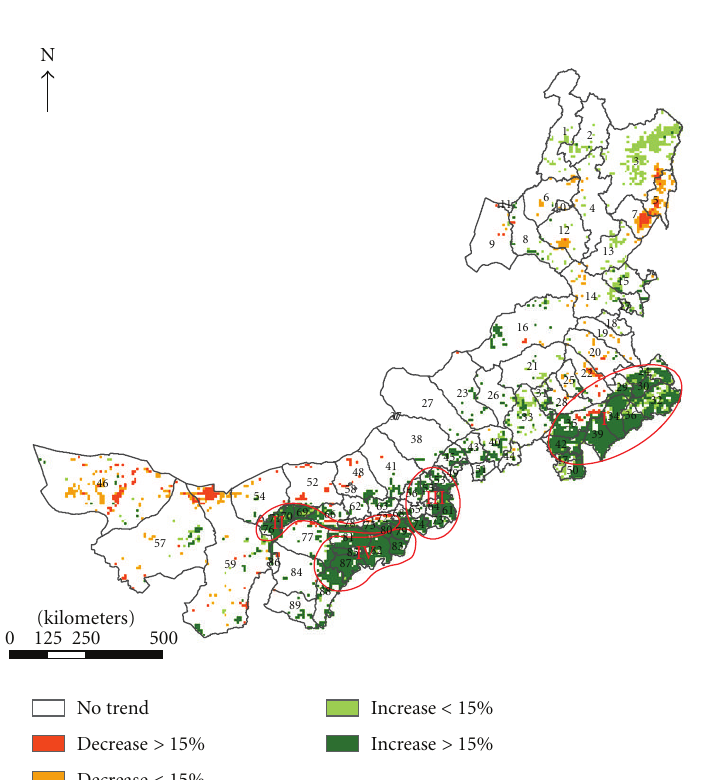
Figure 2: Overall trends in vegetation changes throughout the period 1982–2006. Percentages expressed changes in integrated monthly maximum GIMMS NDVI during the growing season over the study period. The significance of regression models was at the 0.05 level. 16.7% of the study area showed a significant increase trend. The area where integrated NDVI significantly increased mainly distributed in four regions: I (Banner or county ids: 24, 29, 30, 32, 34, 35, 36, 39, 42, 47, 50), II (Banner or county ids: 69, 70, 71, 72, 75, 76), III (Banner or county ids: 53, 55, 56, 61, 64, 73, 74), IV (Banner or county ids: 79, 81, 82, 83, 85, 87,